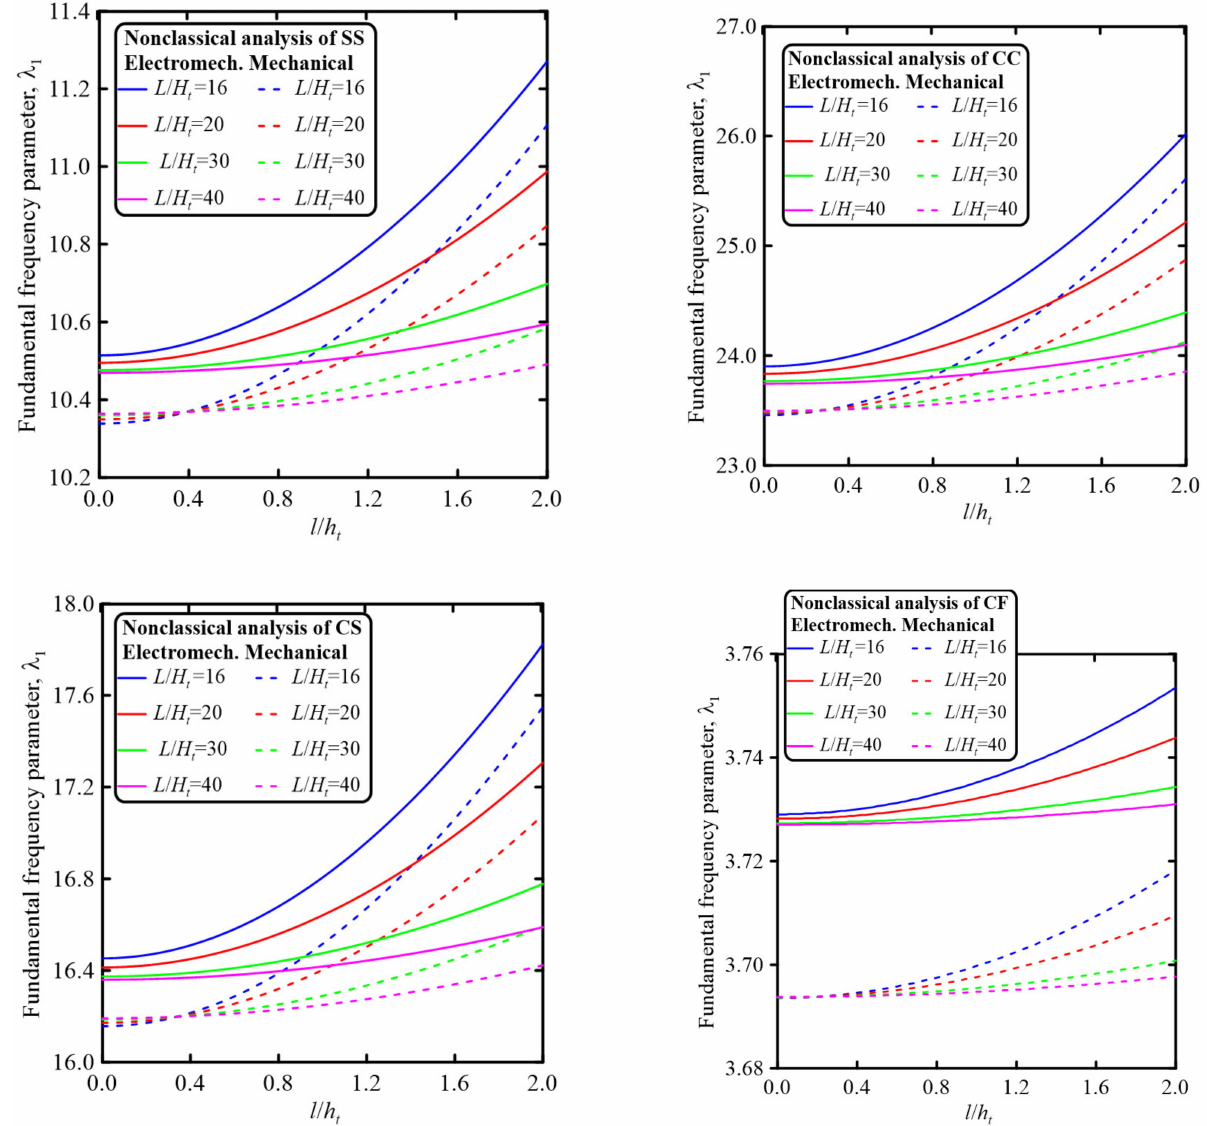
Figure 4. Variation of the fundamental frequency parameter λ 1 with the normalized strain gradient parameter l / h t at different values of the beam aspect ratio L / h t for nonclassical electromechanical and mechanical analyses of piezoelectric sandwich nanobeams for different beam boundary conditions at − 4.1 C/m 2 , µ × 10 − 8 C/m, and a × 10 − 9 C/m 2 α = 0.5, N = 4, e 0 a = 0 nm, e 311 = 3111 = 5 33 = 7.124